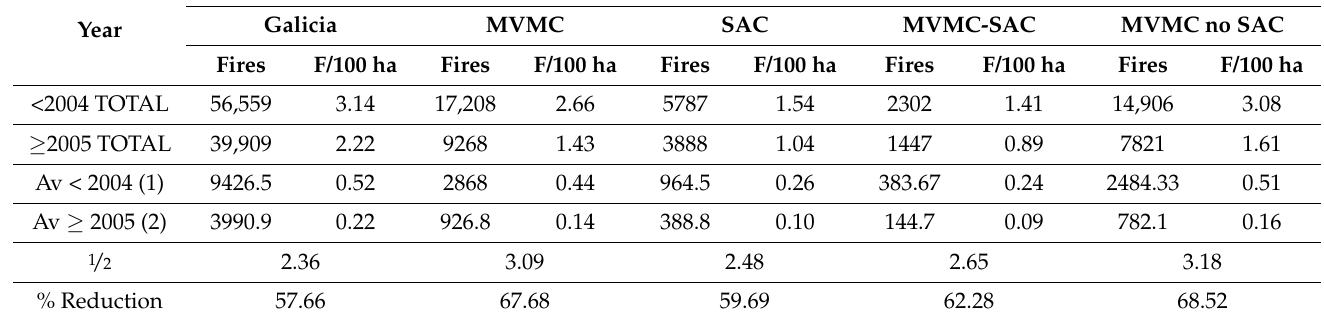
Table 2. For each territorial unit studied, table shows the number of human-caused forest fires and the rate of forest fires (fires/100 ha). The differences between the periods studied are shown in two ways: through a quotient of the averages (<2004/ ≥ 2005) and through the percentage reduction observed in the forest fire rates (fires/100 ha).